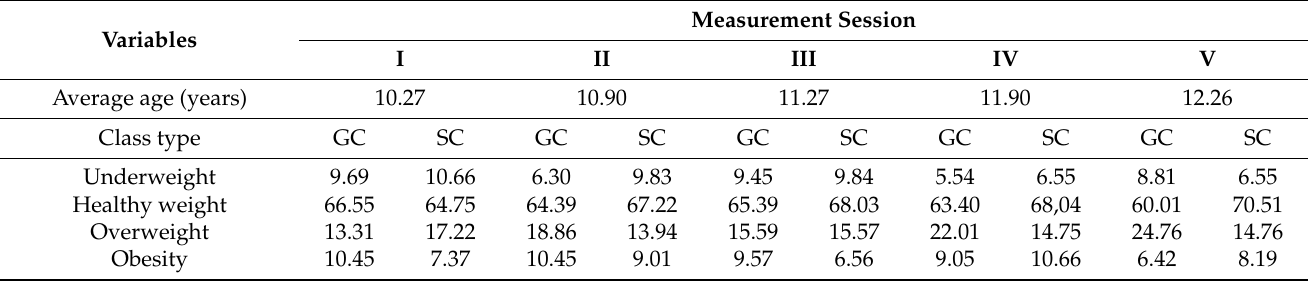
Table 1. The percentage of body mass categories in the GC and SC children during the course of the study.